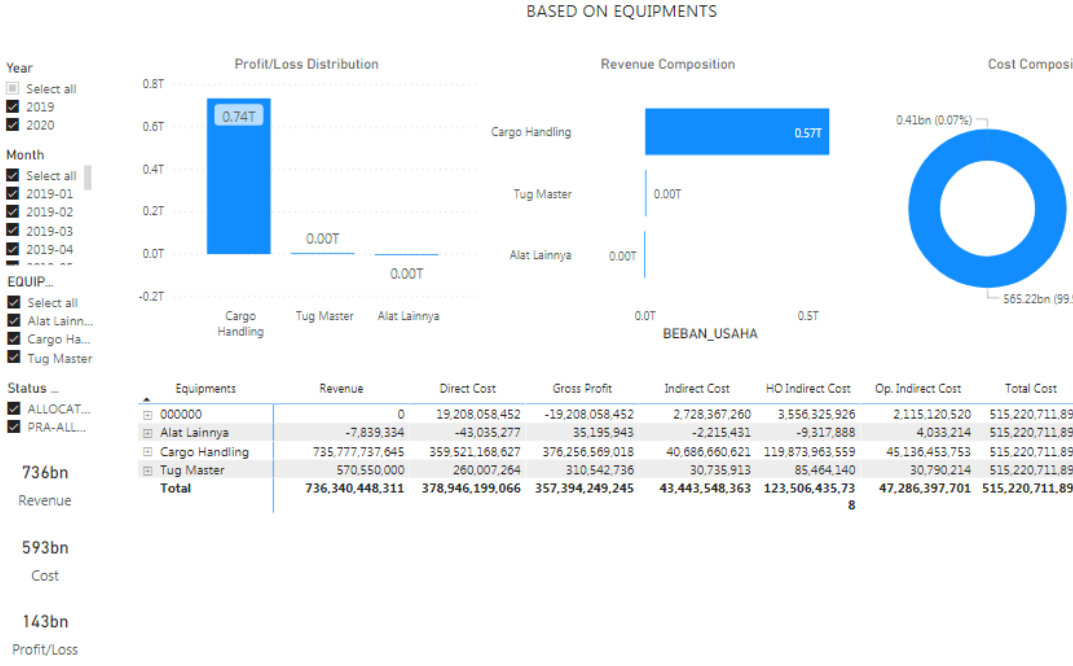
Figure 14: Cost Accounting Dashboard based on Equipments